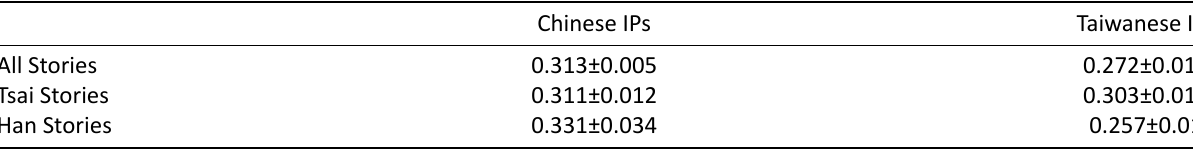
Table 6. Mean disagreement ratio between Chinese and Taiwanese IP